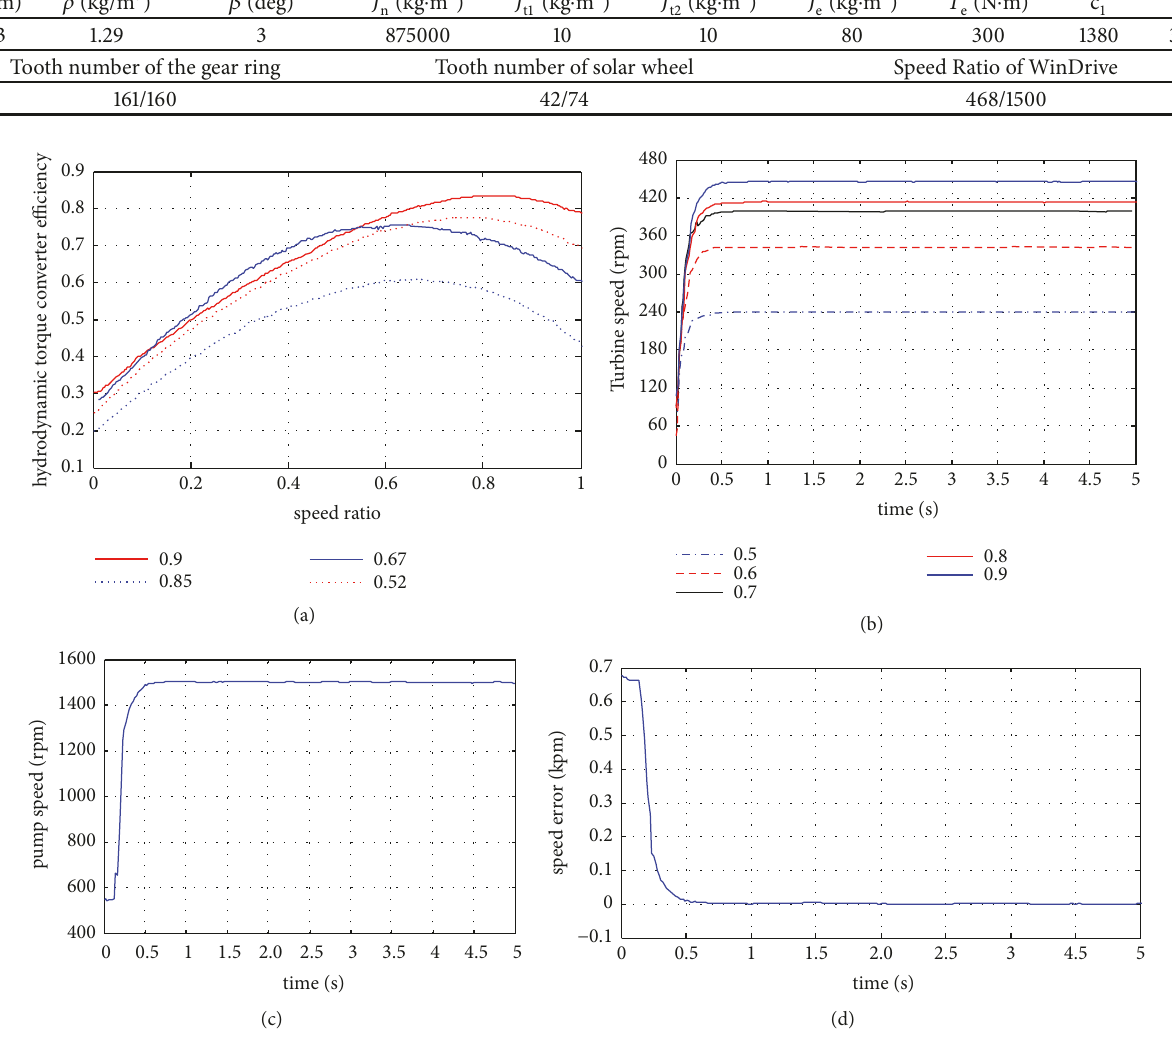
Figure 7: Performance of the proposed